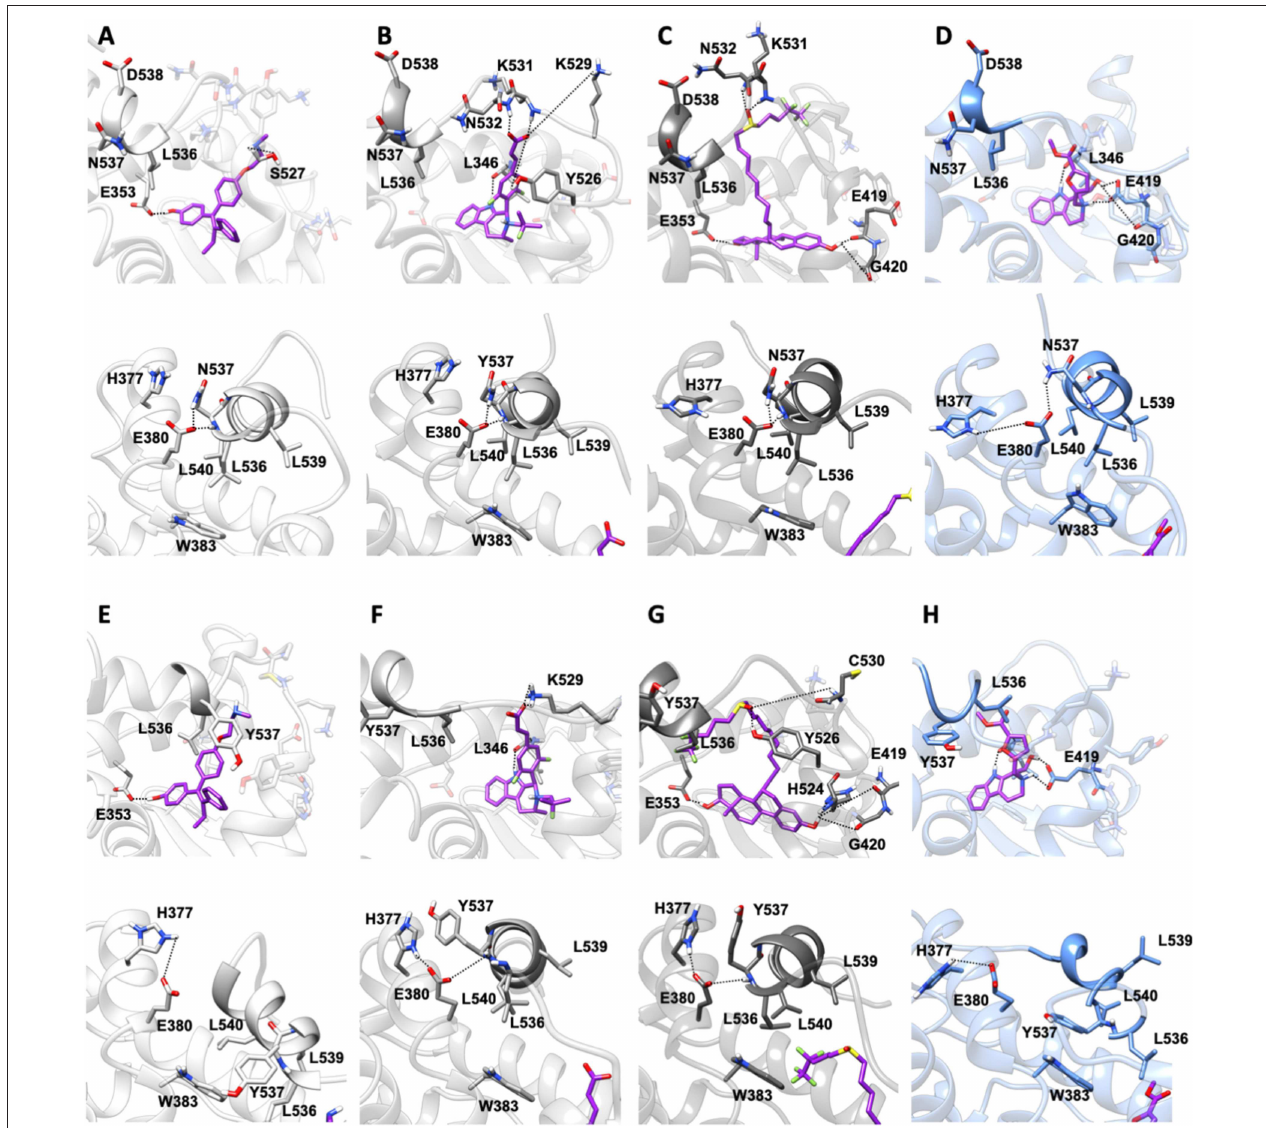
FIGURE 7 | Binding of compound 19 to Y537N and D538G ER α as compared with END, AZD and FULV. Binding to Y537N: (A) END; (B) AZD; (C) FULV; (D) Compound 19 . Binding to D538G: (E) END; (F) AZD; (G) FULV; (H) Compound 19 . Top panels show their placement in the ligand binding cavity, while bottom panels display a close view of E380 H-bond network induced by each ligand. Inhibitors are shown in licorice with carbon atoms in purple color, while oxygen and nitrogen in red and blue, respectively. Protein is shown in gray new cartoons for END, AZD, FULV, and in blue new cartoons for 19 , respectively.